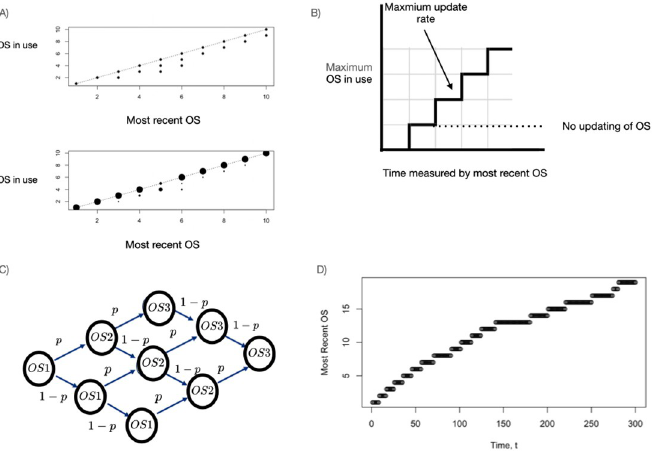
Fig 2. Visual description of the problem when the cyber components have multiple possible OSs that are updated as time goes forward and cyber components do not return to a previous OS. A) Two representations of the OS in use (y-axis) in a subset of about 335 computers from a network of about 7000 computers between July 2019 and March 2020 (details on how the data were chosen can be found in S1 Appendix in S1 File) as a function of the most recent OS release (x-axis). In the upper panel, we show the data as presence/absence of an OS in the sample. In the lower panel, we show the relative distribution of the current OS, where the diameter of the circle is proportional to the base-10 logarithm of the counts of that OS. The points (5,3) and (10,9) from the upper panel are not visible in the lower panel because their relative representation is so small. B) When measured by the most recent OS, time moves forward in uniform steps (x-axis), and the maximum OS in use jumps whenever a new OS is released. The maximum updating rate is then the black solid line; if an OS is never updated, it remains at the first release (dotted line). Each location between these two lines corresponds to a probability of the OS in use given the most recent OS. C) With time measured in OS release, the space between the two lines in panel B can be filled using a binomial lattice model ( sensu Leisen and Reimer [22]) in which the current OS, at the time of an OS update, is either updated by 1 or remains the same. We let p denote the probability that the OS is updated at each step possible. For example, the probability that at time t the OS is still the first release is (1 − p ) t − 1 (i.e., in each of the t time steps the OS was not updated) and the probability that the OS is the most recent release is p t (i.e., in each of the t time steps the OS was updated). D) However, in this paper we are interested in measuring time in a natural scale, such as days. In that case, we require knowing the most recent OS release as a function of time. We use the schedule of OS updates shown here for the computations that